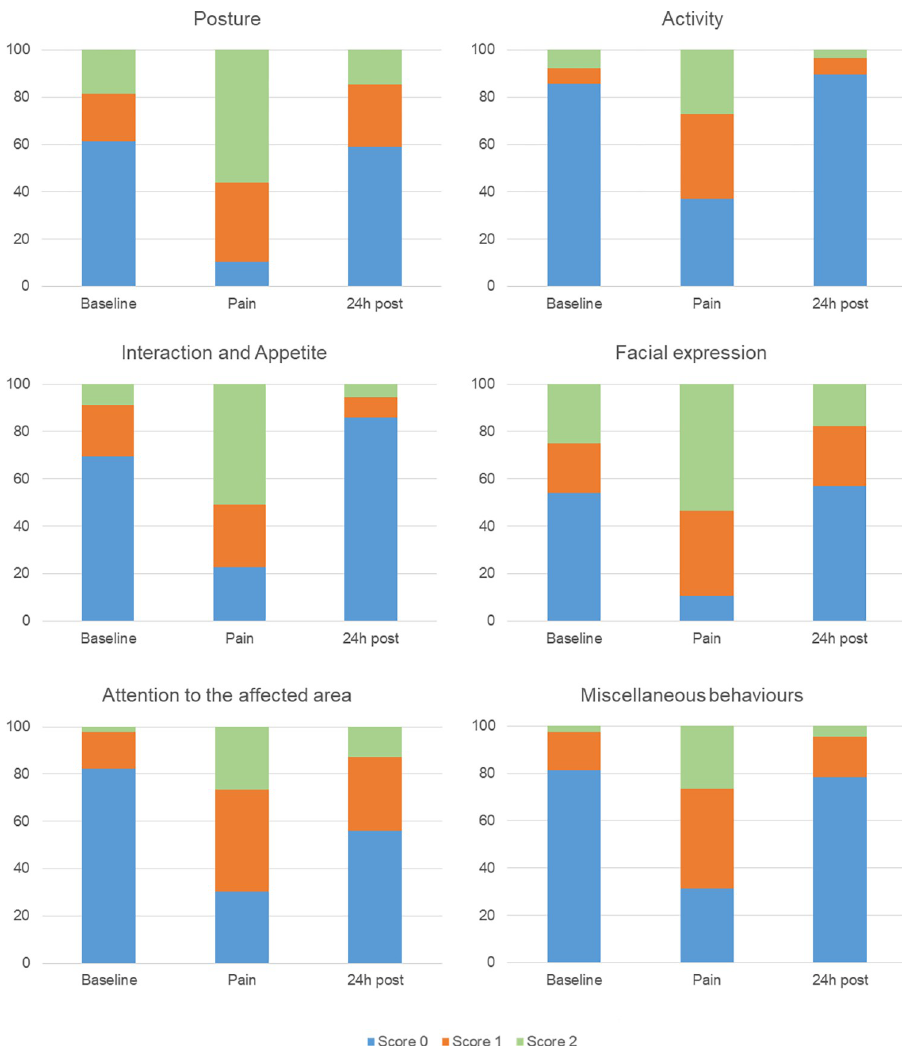
Fig 2. Frequency of the presence of scores of each item of the RPBS. Score 0 –blue, Score 1 –orange, Score 2